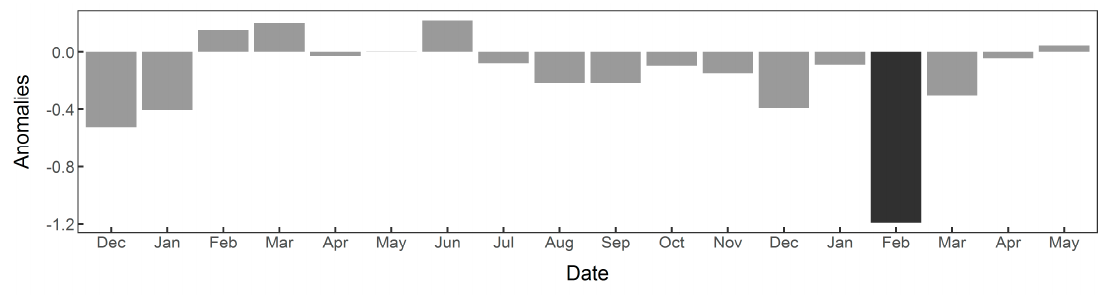
Figure 4. Monthly anomalies in the NAO index from the month of the celebration of the rogation ceremonies (right end of the x axis) to two winters back in time (left end of the x axis). Dark grey bar is the statistical significant anomaly at the 95% confidence level.